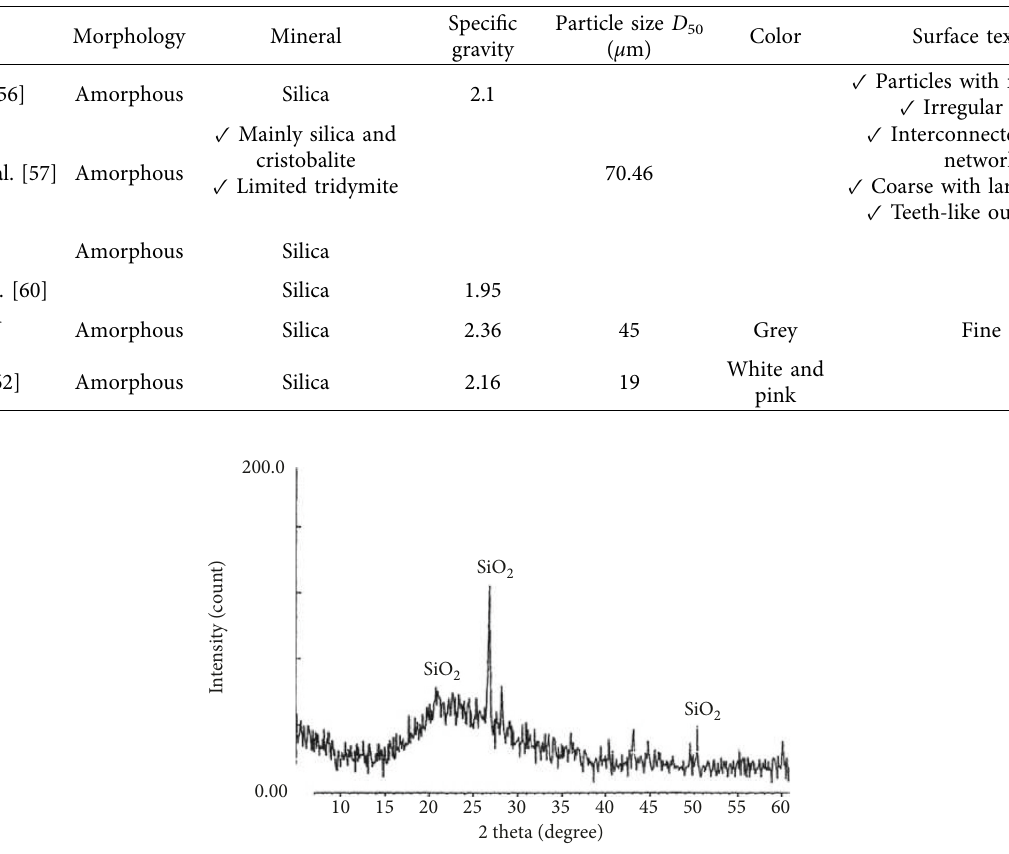
Figure 10: XRD pattern of rapid cooled RHA [56]. (a) [57]. (b) [56].